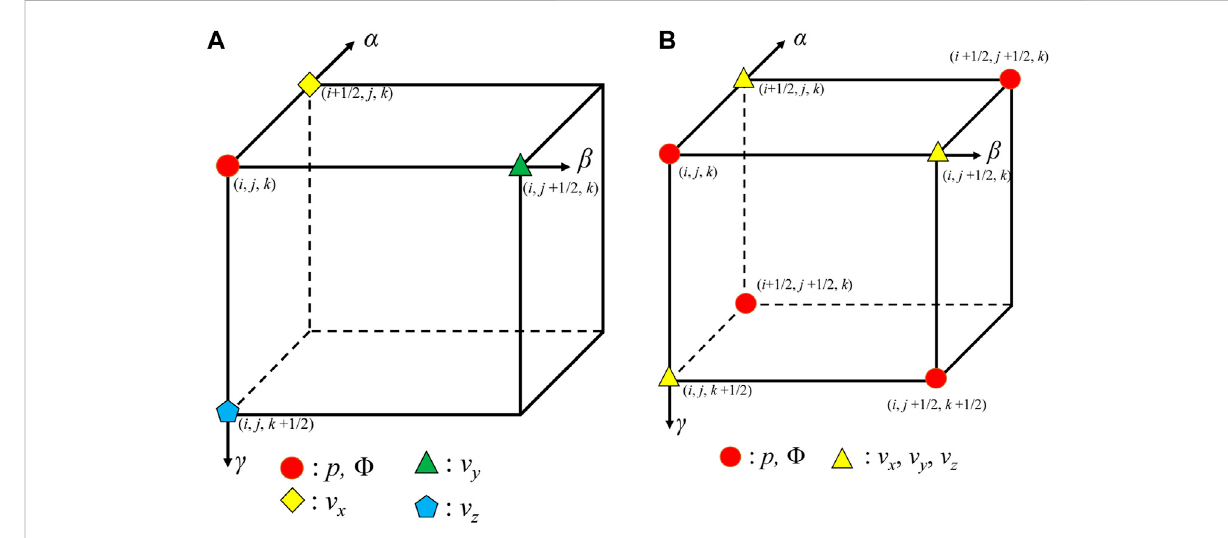
FIGURE 2 Comparison of the node distribution in the standard (A) and fully (B) staggered-grid fi nite-difference methods. p denotes the pressure wave fi eld, Φ denotes the memory variable, and v x i ( x i = x , y , z ) denotes particle velocity.